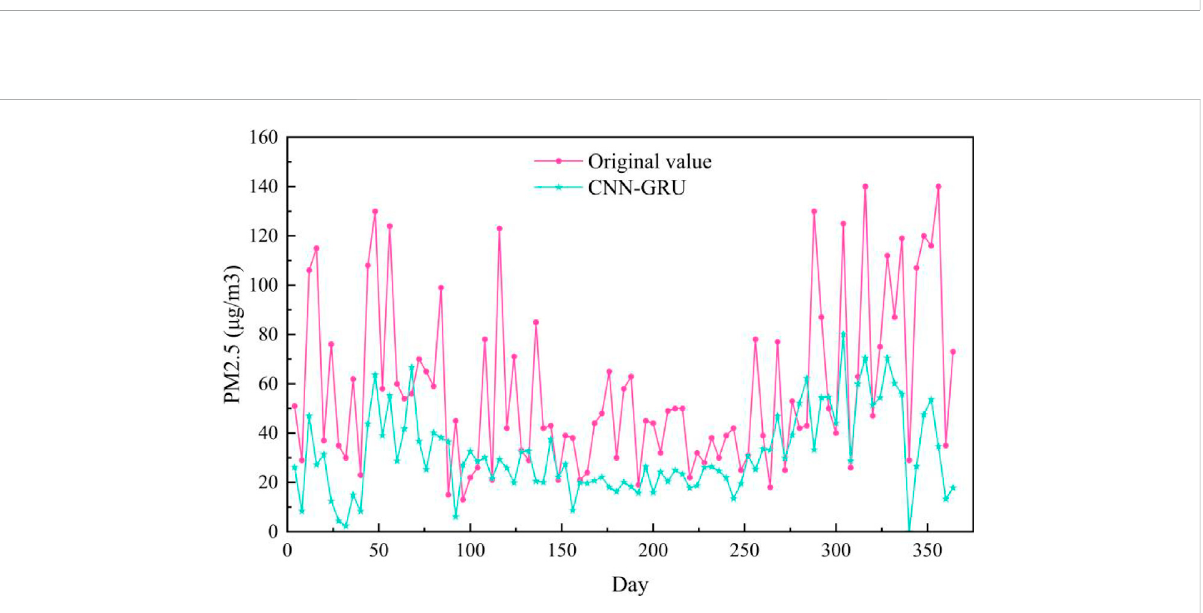
FIGURE 10 Experimental results of CNN-GRU method in Baoding test